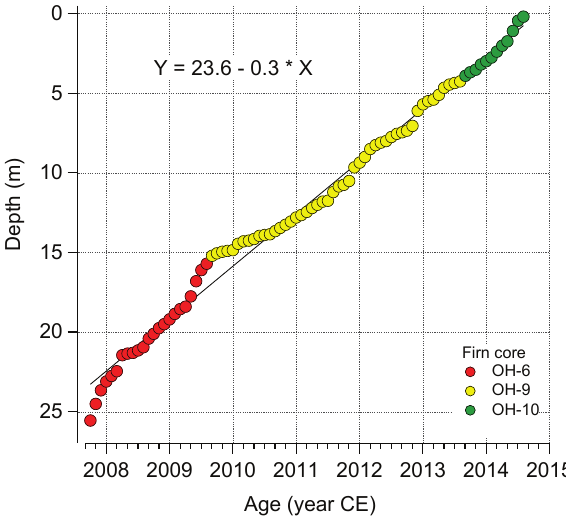
Figure 8. Depth-age model for firn cores OH-6, OH-9 and OH-10 retrieved from Laclavère Plateau. The linear relationship between depth and time was constructed based on the cores measured d excess oscillation and a synthetically constructed d excess from meteorolog- ical observations. Note that the depth axis was intentionally inverted to visualize the surface (0m) on